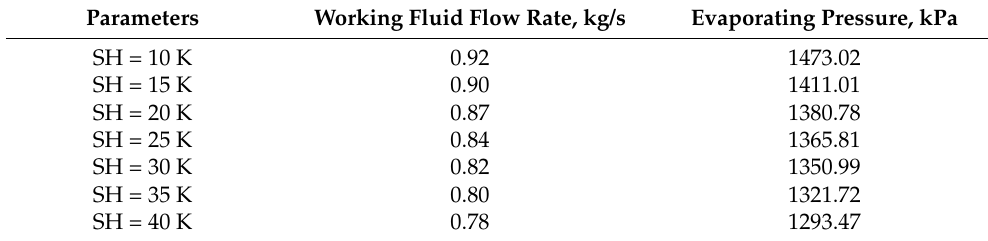
Table 3. Operation parameters of the ORC system under different superheat degrees.